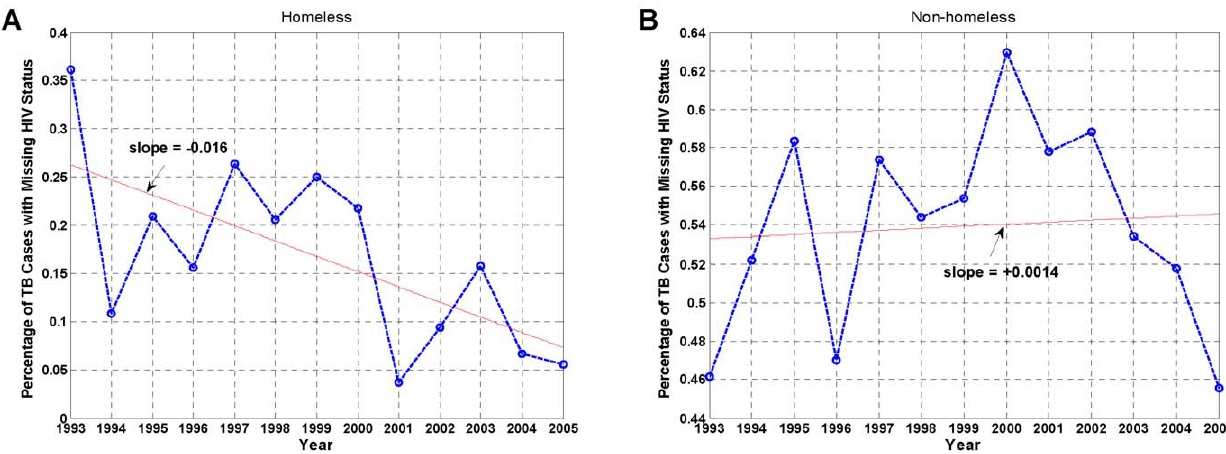
Figure 2. Annual percentage of TB cases with missing HIV status, January 1993–December 2005. (A) Homeless. (B) Non-homeless. While the reporting of HIV status has improved over time among the homeless TB cases (negative slope), it has remained more or less constant among the non-homeless TB cases (small positive slope). Red line: linear fit.